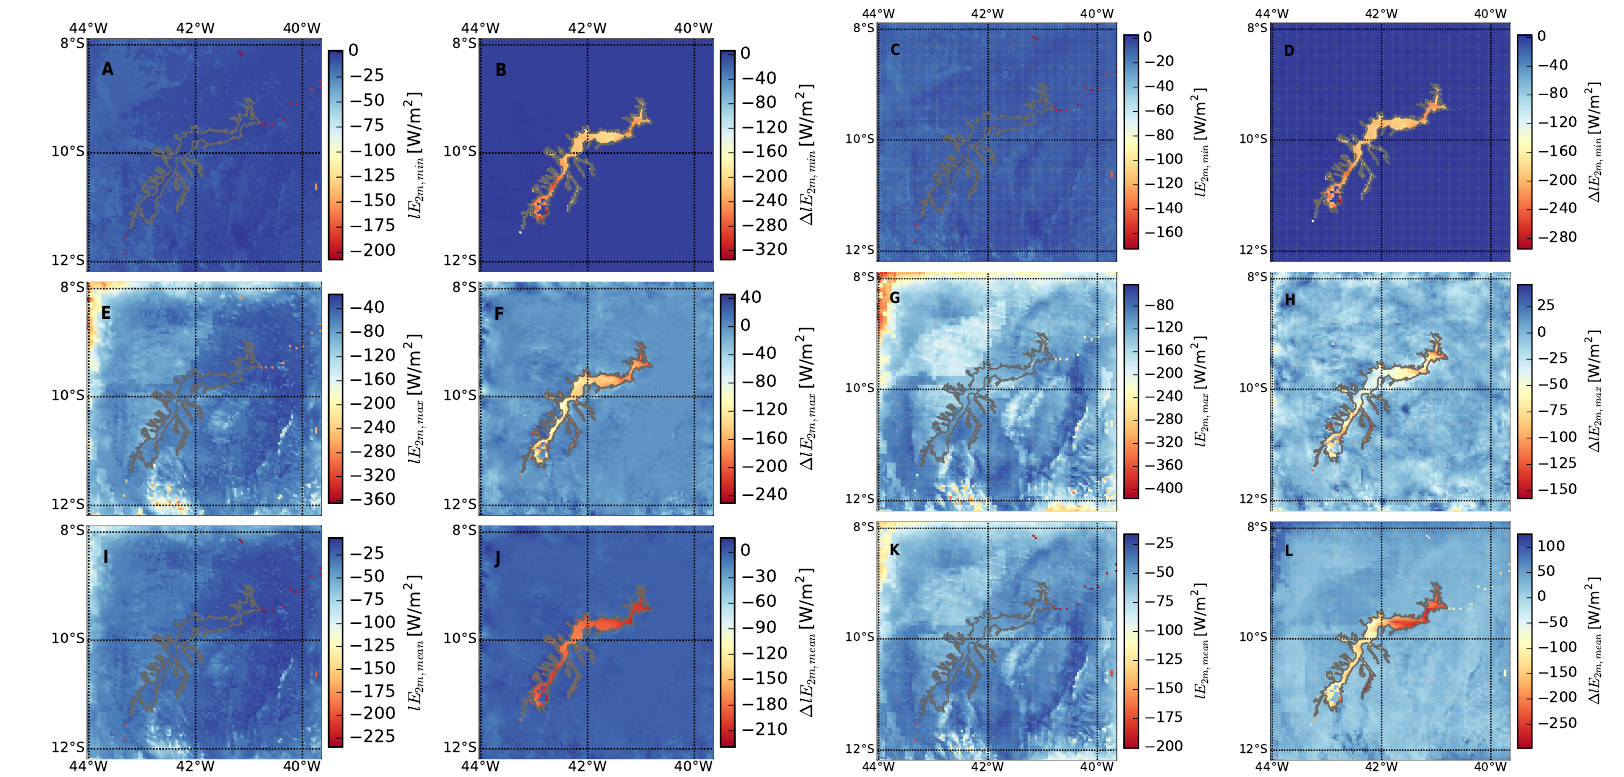
Figure 6. Same as in Figure 4 for the latent heat